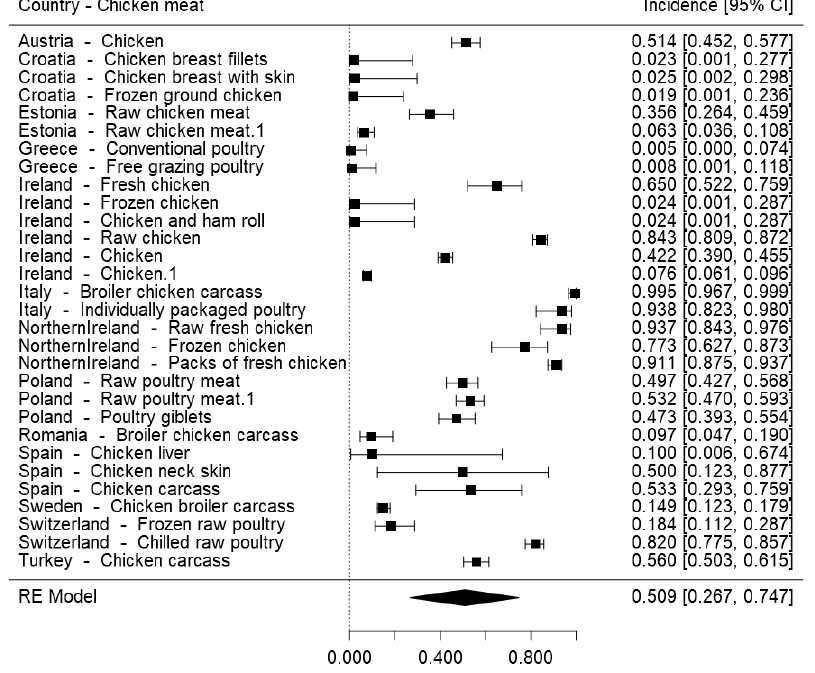
Figure 2. Forest plot of the incidence of Campylobacter spp. in chicken meat surveyed in European establishments.